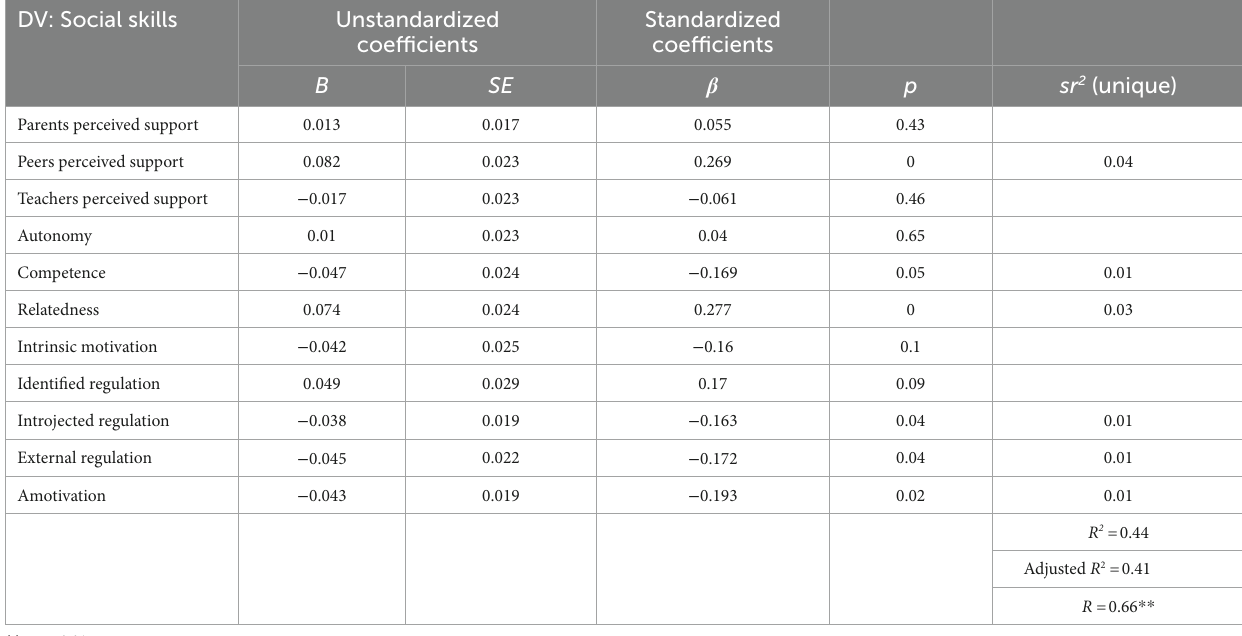
TABLE 2 Standard multiple regression